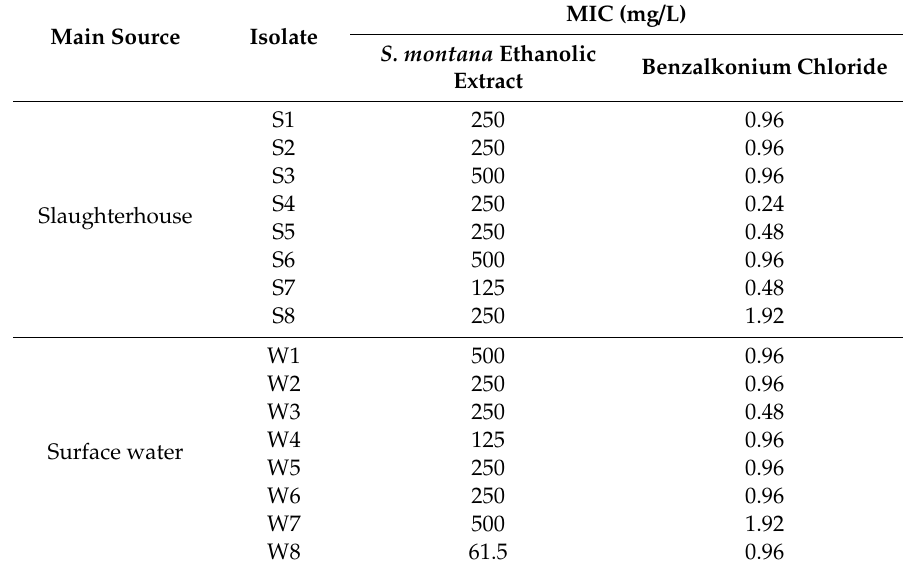
Table 2. Susceptibilities of the individual Campylobacter jejuni slaughterhouse and surface-water isolates to the Satureja montana ethanolic extract and benzalkonium